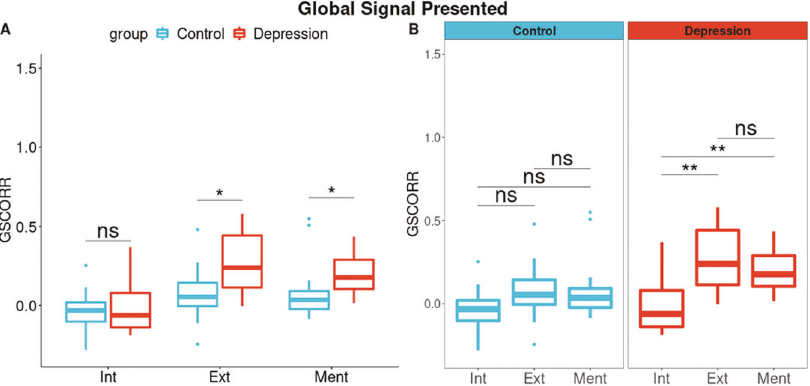
Fig. 2 Comparison of GSCORR. A In Wilcoxon test, the MDD group shows greater GSCORR in exteroceptive (Mdn = 0.239, p < 0.05) and mental (Mdn = 0.177, p < 0.05) layers. B Three-layer GSCORR compared with each other with the Wilcoxon test. The group with MDD exhibits higher GSCORR in exteroceptive and mental layers compared to GSCORR in the interoceptive layers. No difference exists for the control group. Int = Interoceptive, Ext = Exteroceptive, Ment = Mental. * denotes p < 0.05 and ** denotes p <